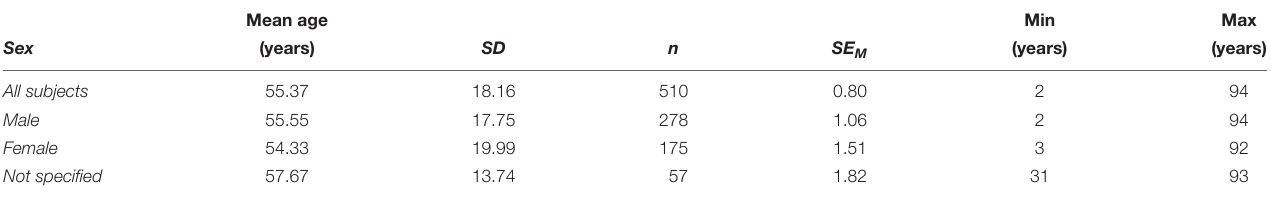
TABLE 2 | Summary statistics for age of patients in toto and by